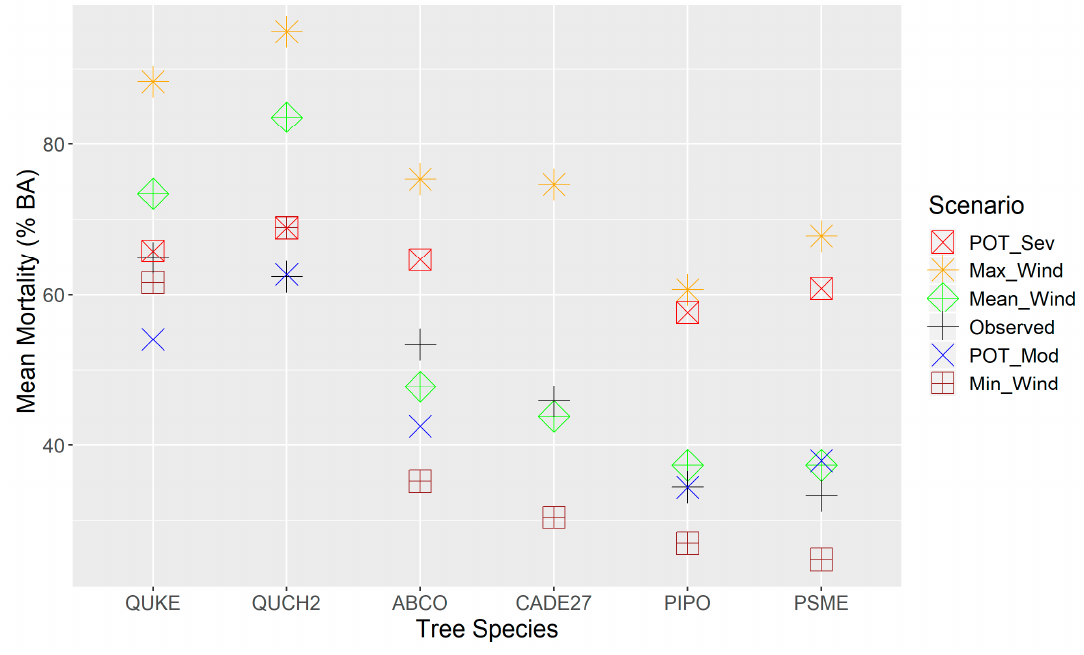
Figure 2. Mean fire-induced mortality as a percent of pre-fire, live tree basal area for modeled weather scenarios and observed by forest type group.